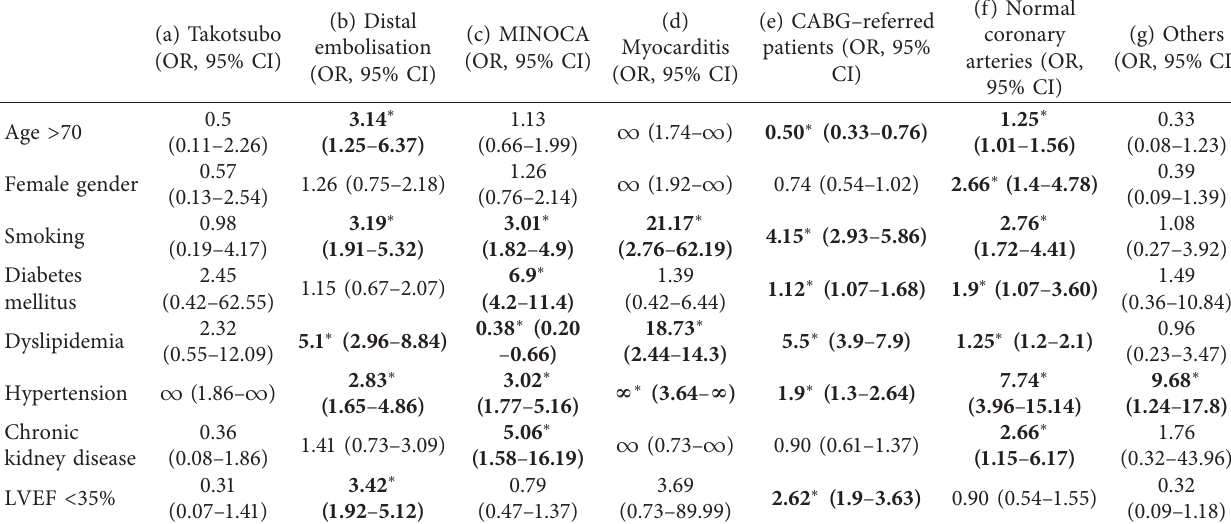
Table 2: Univariate analysis of selected study subgroups and cardiovascular risk